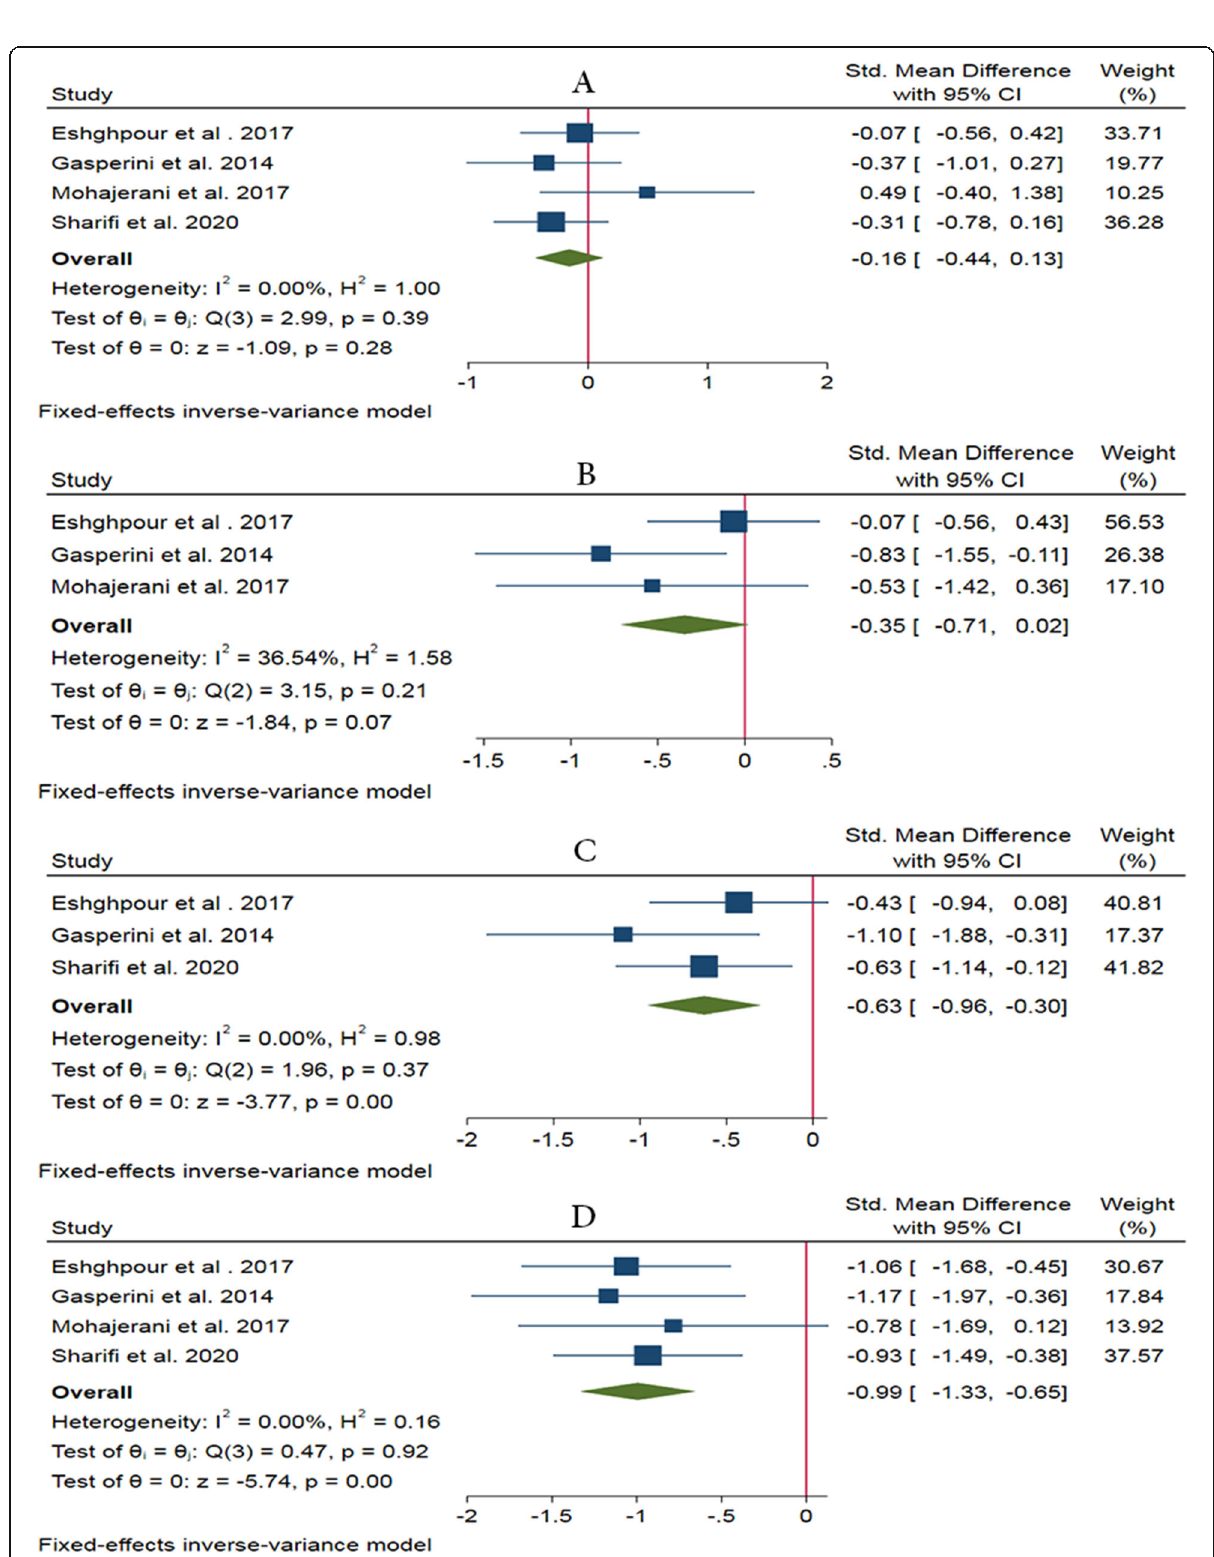
Fig. 4 Forest plots of two-point discrimination test showing the effectiveness of LLLT in a short period (0 to 48 h) ( a ), after 2 weeks ( b ), 1 month ( c ), and 2 months after BSSRO ( d